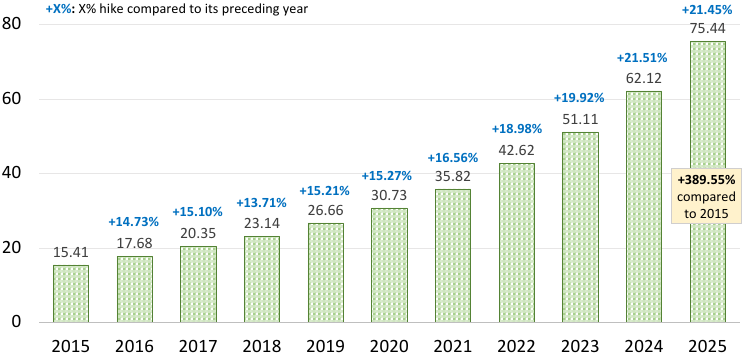
Figure 1. Connected IoT devices (in billions) from 2015 to